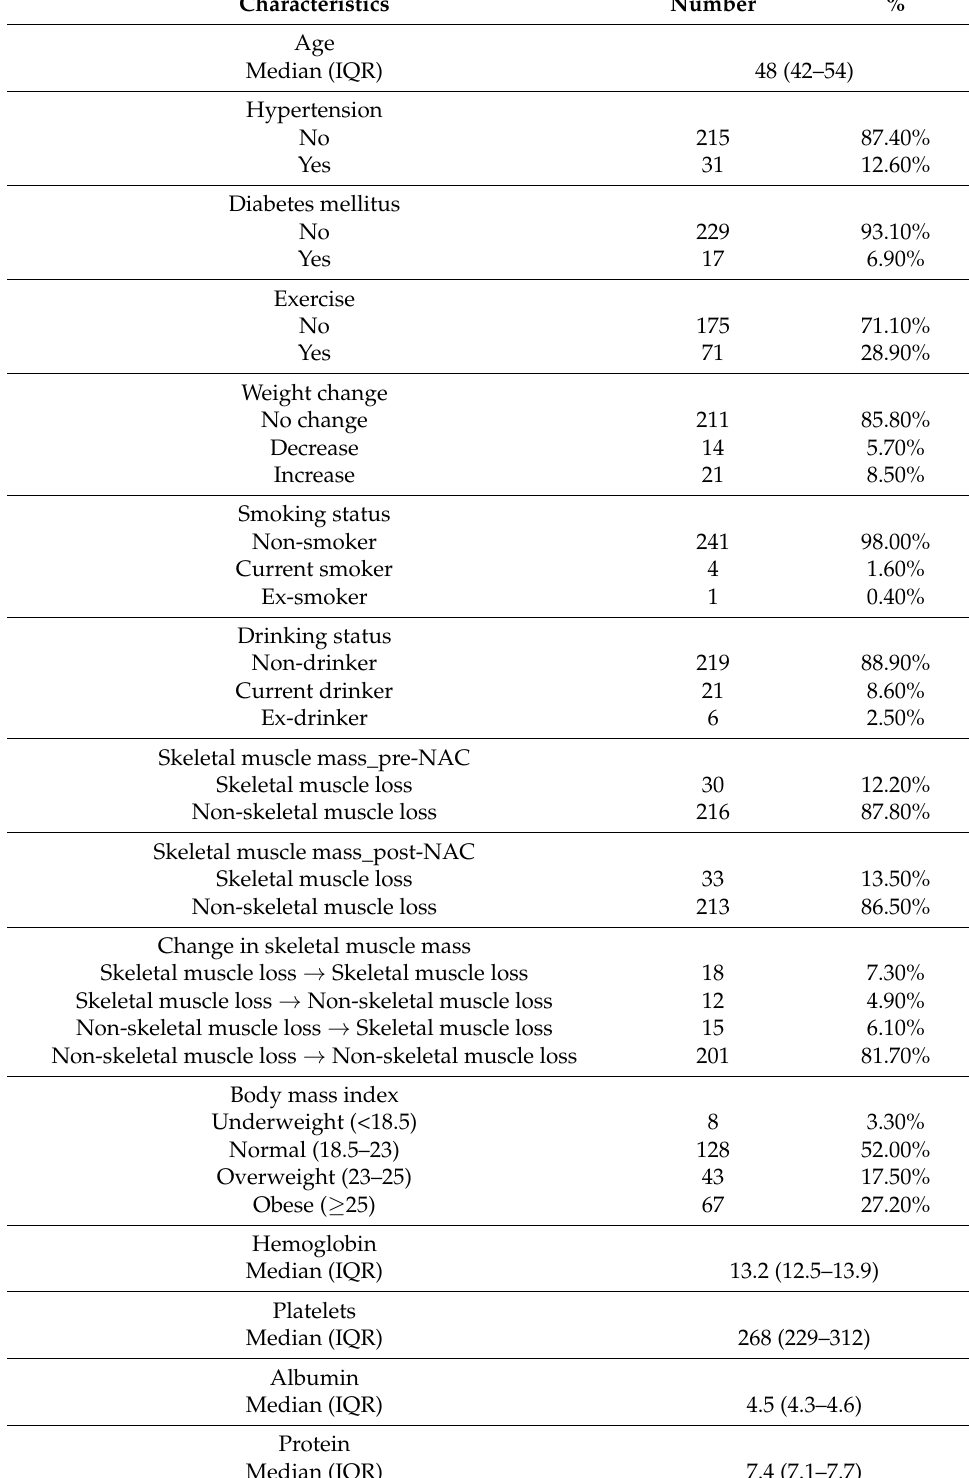
Table 1. Patient